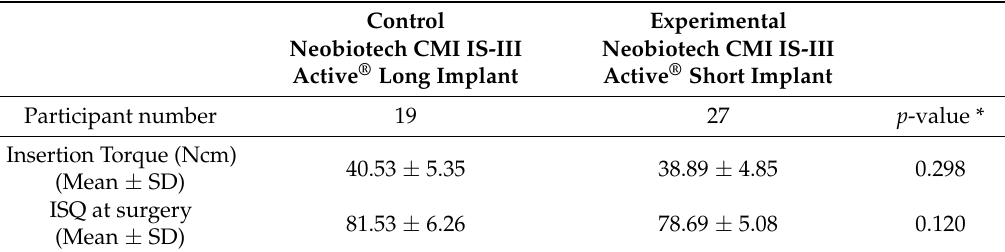
Table 2. Comparison of primary stability between the long and short implants.